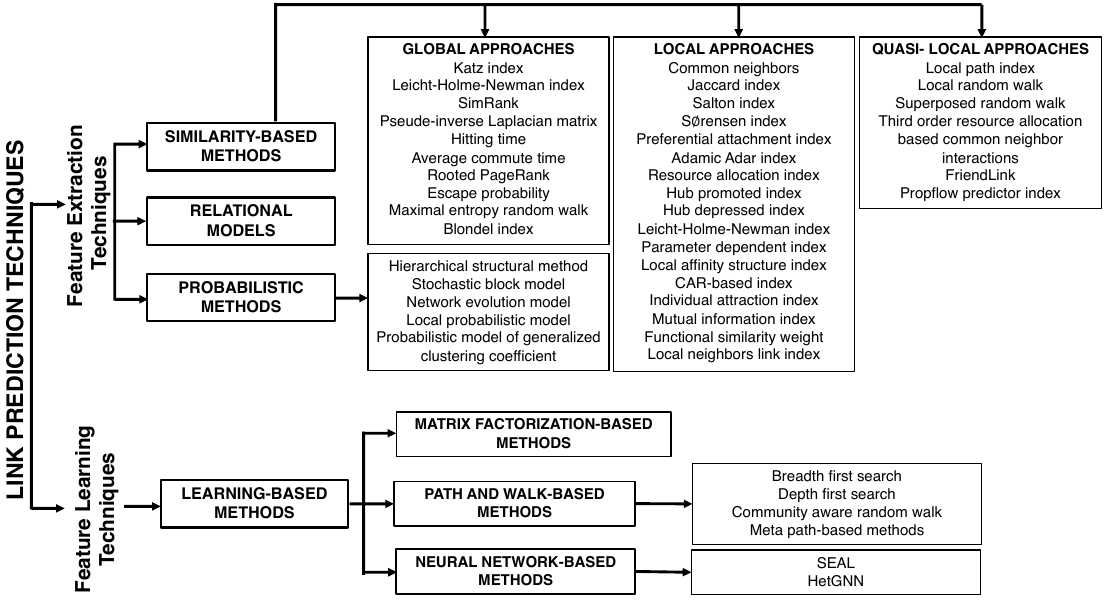
Figure 7. A taxonomy for the feature extraction techniques and feature learning methods in link prediction